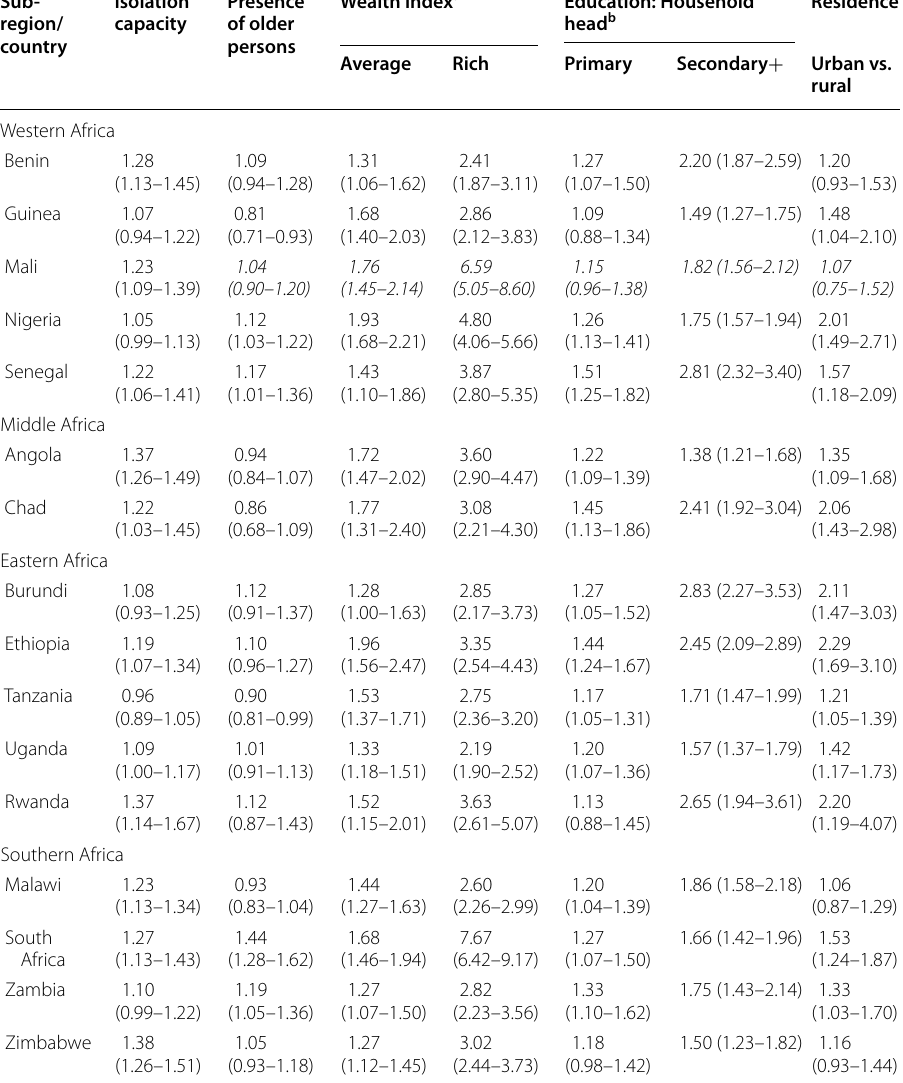
Table 2 Adjusted Odds Ratio (OR) for association between household characteristics and handwashing capacity in selected African